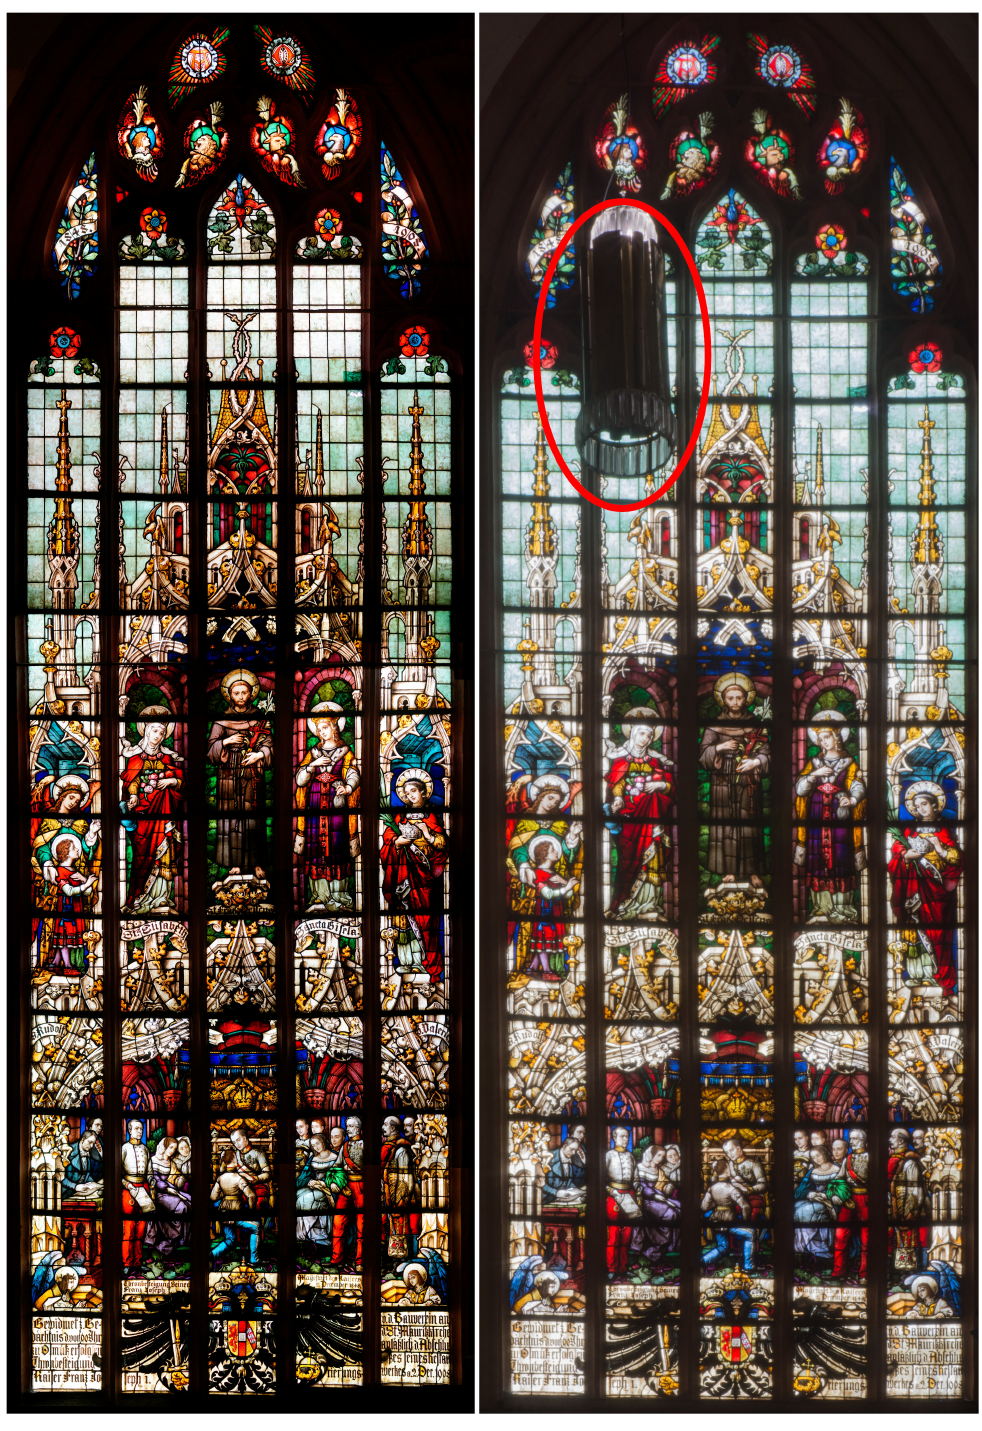
Figure 10. Comparison of the image of the stained glass composed from the images captured by an onboard camera of an unmanned aerial vehicle ( left ) and static camera mounted on the tripod at the floor of the temple ( right ). Besides a worse quality of the image with respect to capturing real-world dimensions of an object, the image captured by a static camera includes an area occluded by the chandelier (highlighted by a red ellipse), which is inevitable when capturing images from the